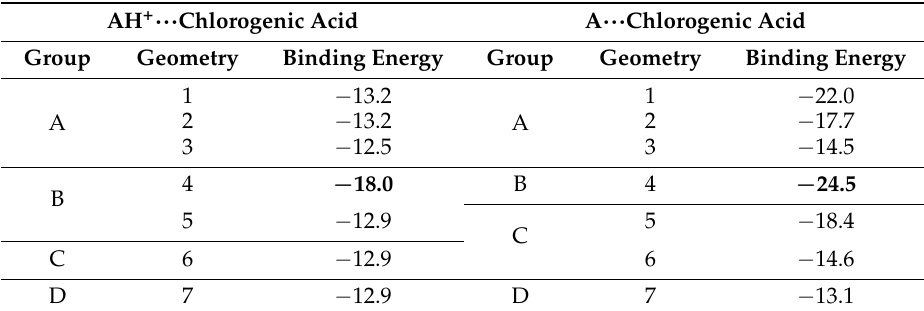
Table 3. Association energies (kcal · mol − 1 ) of PA1 (in both AH + and A forms) with chlorogenic acid. Groups A, B, C and D are defined according to geometry similarity (see text and Figure 11). The association energies of the most stable conformers are highlighted in